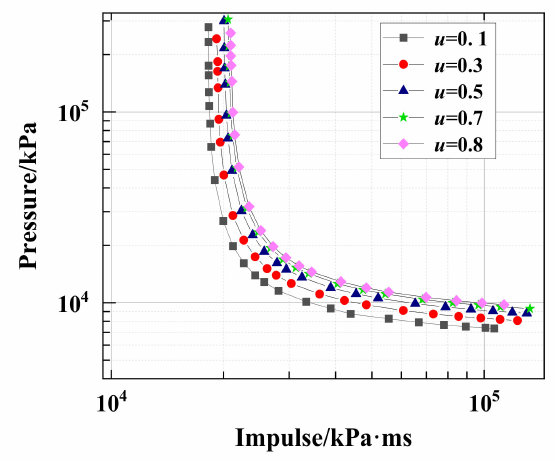
Figure 25. P-I curves for shear response with different axial compression